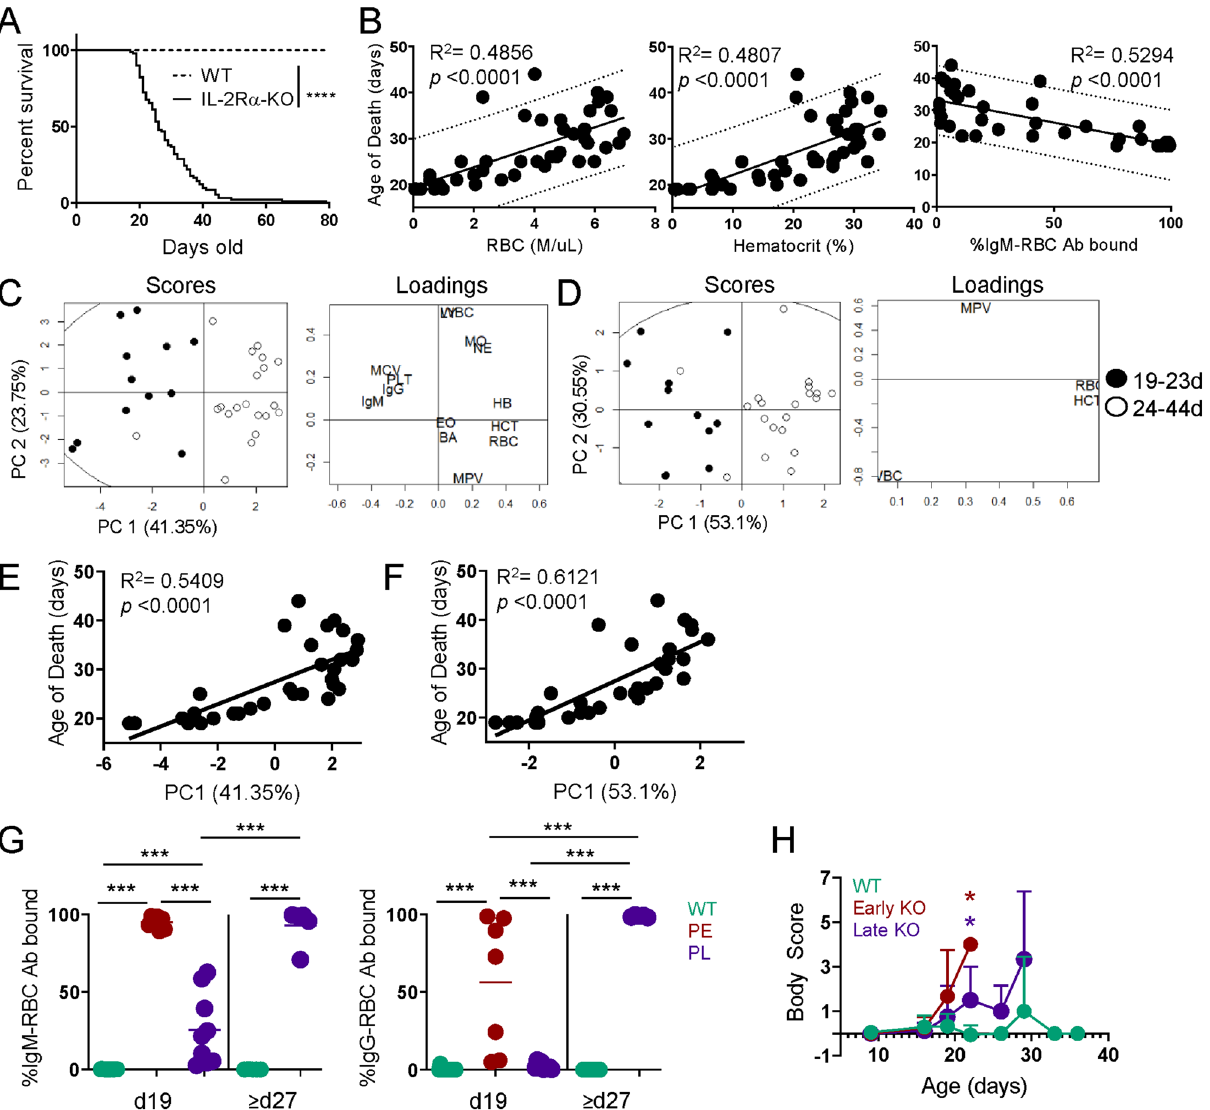
Figure 1. Early RBC characteristics predict IL-2Rα-KO disease kinetics. ( A ) Kaplan–Meier survival curves for WT and IL-2Rα-KO mice. Statistics: log-rank (Mantel–Cox) test, *** p < 0.001; n = 90 IL-2Rα-KO and 47 WT mice. ( B ) Dot plots and linear correlations for data collected from day 19 CBC and RBC Ab binding were tested against the age of death of IL-2Rα-KO mice. Pearson correlations with the highest R 2 values are shown. Dotted lines indicate the 95% prediction interval. Statistics: p values shown on graphs indicate whether the slope of the linear regression is significantly non-zero; n = 44 (RBC and HCT), n = 36 (IgM). ( C , E ) PCA by singular value decomposition was performed on peripheral blood collected from 19-day old IL-2Rα-KO using 14 variables or ( D , F ) 4 variables. Percentage on the axis indicate the amount of variance in the data that the principal component explains. ( E , F ) PC1 is shown against the age of death of the mice. Pearson R 2 values are shown. Statistics: p values shown on graphs indicate whether the slope of the linear regression is significantly non-zero. n = 32 mice. ( G ) The frequency of RBC bound by IgM or IgG antibodies at day 19 and late endpoint (d27+). n = 7–15 mice per group for day 19, n = 5 mice per group for day 27 or older. Statistics: one-way ANOVA with multiple comparisons ***p < 0.001. ( H ) Body score of IL-2KO and WT mice are shown from day 9 onward. n = 4 (PE), 11 (PL), 36 (WT) mice. Statistics: multiple t tests with Bejamini–Hochberg FDR correction; *p < 0.001. Standard CBC abbreviations are used 67